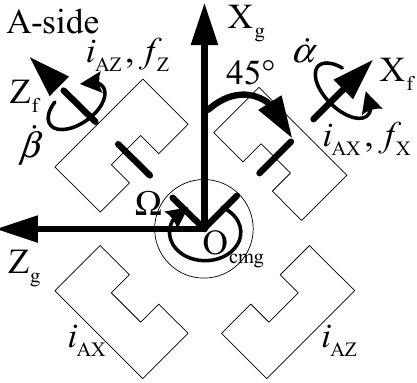
Figure 3. Sketch map of the magnetic bearing